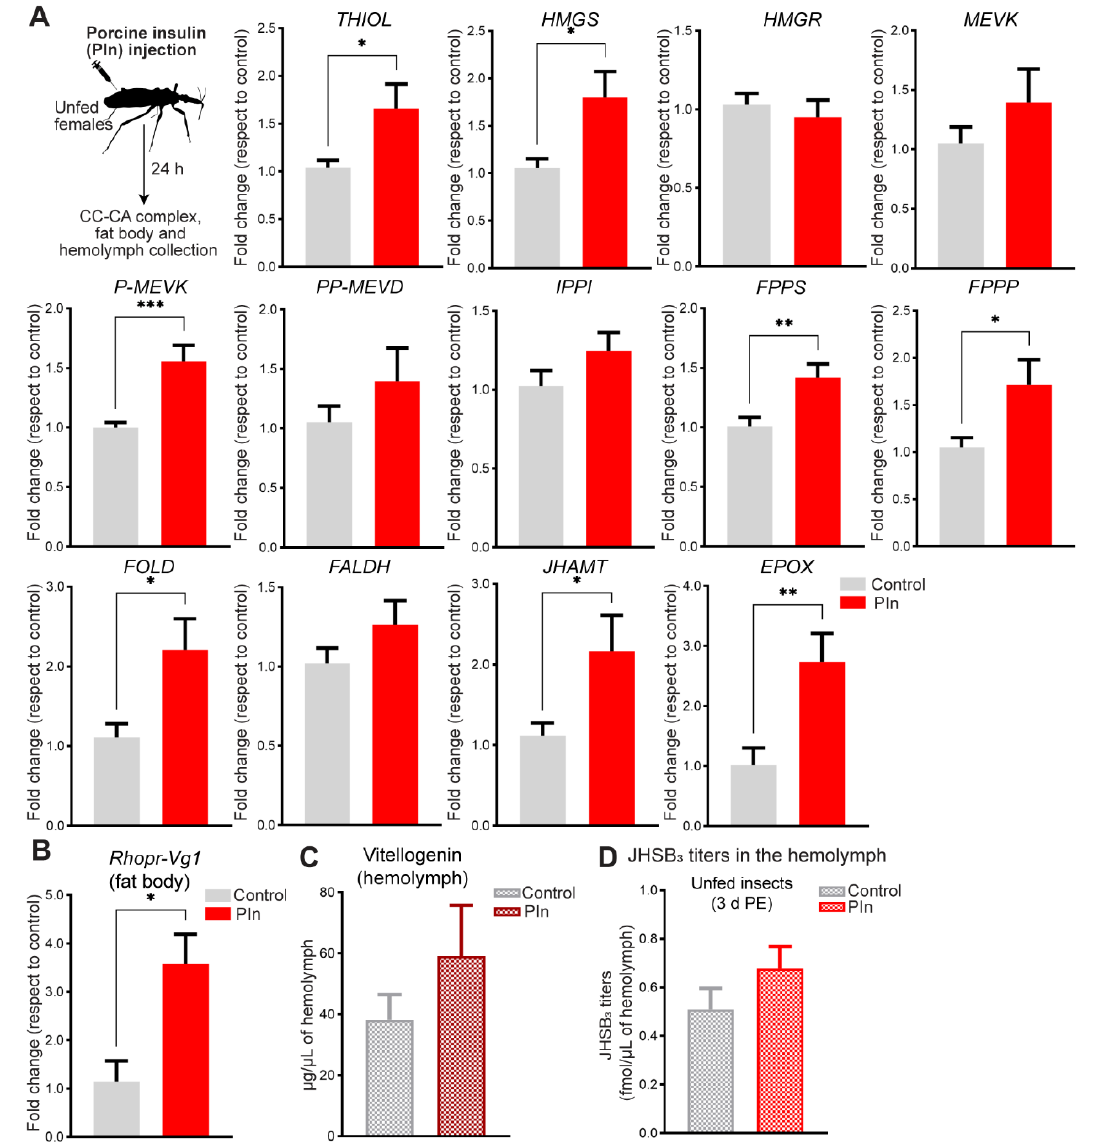
Figure 2. Role of insulin in JHSB 3 production in in vivo assays. ( A ) Unfed adult females were injected with porcine insulin (PIn, 0.5 µg) and 24 h later, the CC-CA complexes were dissected to measure transcript expression of the JH biosynthetic enzymes. Transcript levels were quantified using RT- qPCR and analyzed by the 2 - ΔΔ Ct method. The y axes represent the fold change in expression relative to control (saline injection, gray column, value ~1) obtained via geometric averaging using Rp49 and actin as reference genes. The results are shown as the mean ± SEM ( n = 5, where each n represents a pool of CC-CA complexes from 3 insects). * p < 0.05; ** p < 0.01; *** p < 0.001 (Student’s t -test). ( B ) Effect of insulin injection on Rhopr-Vg1 mRNA expression. Transcript levels were quantified in the fat body using RT-qPCR and analyzed by the 2 - ΔΔ Ct method. The y axis represents the fold change in expression relative to control (saline injection, gray column, value ~1) obtained via geometric averaging using Rp49 and actin as reference genes. The results are shown as the mean ± SEM of n = 5, where each n represents a pool of fat bodies from 3 insects. * p < 0.05 (Student’s t -test). ( C ) Quantification of vitellogenin in the hemolymph of unfed insulin-injected females by ELISA. The results are shown as the mean ± SEM ( n = 5–6, where each n represents hemolymph from 1 insect). ( D ) Hemolymph was collected from unfed adult females (3 days post ecdysis) 24 h after insulin injection. The y axes represent JHSB 3 titers (fmol) per µ L of hemolymph. The results are shown as mean ± SEM of n = 4–5, where each n is hemolymph from 5–7 insects. d PE, days post